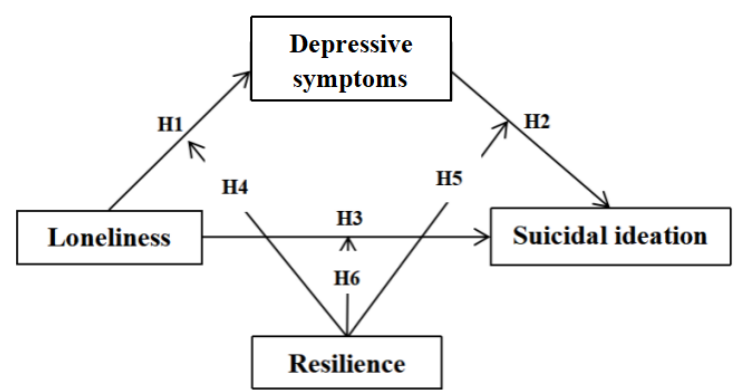
Figure 1. Hypothesis